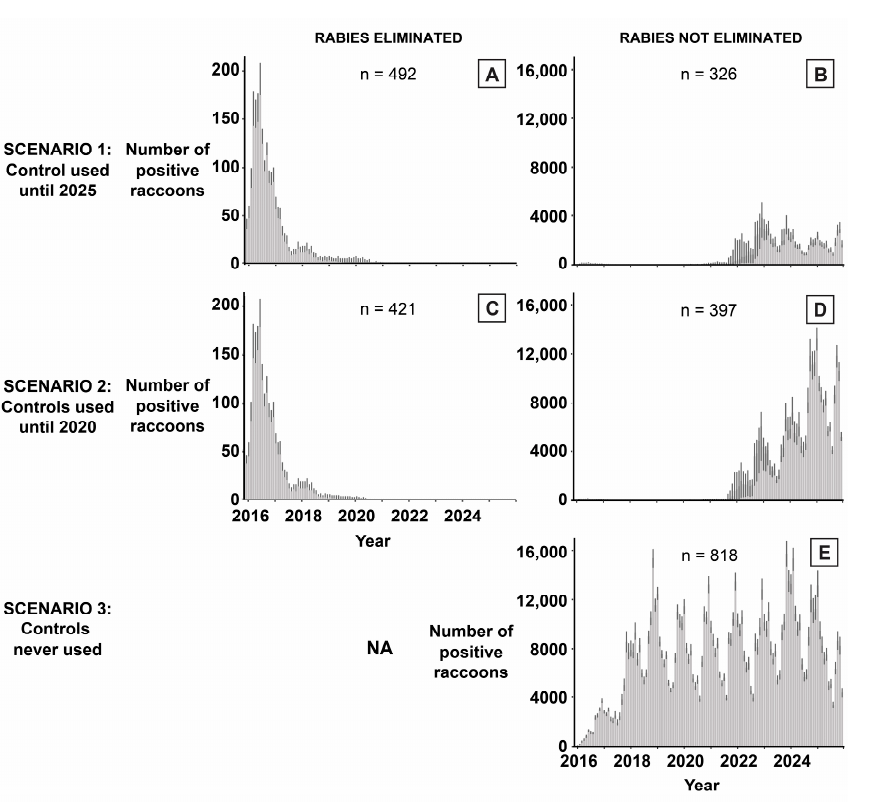
Figure 2. Epicurves showing the predicted median number of new infections of raccoon rabies per month for Scenarios 1, 2, and 3. Median case numbers (grey bars) are shown from November 2015 to December 2025 with upper and lower quartiles (dark lines). Panels ( A , C ) summarize simulations predicting rabies elimination in Scenarios 1 and 2, respectively, and ( B , D , E ) summarize simulations predicting rabies was not eliminated in Scenarios 1, 2, and 3, respectively. The number of simulations summarized per epicurve is shown above each panel. For Scenario 3, rabies was only predicted to be eliminated when the disease died off naturally within the first week following its introduction. Therefore, the epicurve for those simulations was not shown. Due to the scale of the y-axis, cases between November 2015 and December 2020 are not visible.